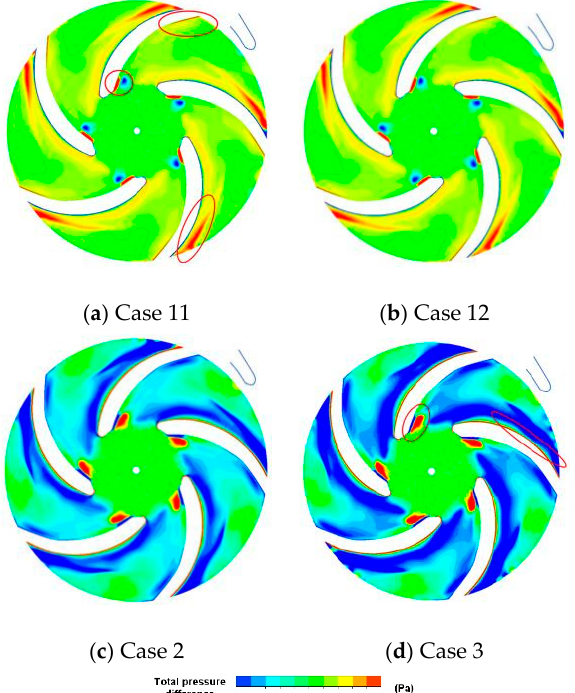
Figure 8 . Distribution of total pressure variation on the center plane in the increasing flow rate section.